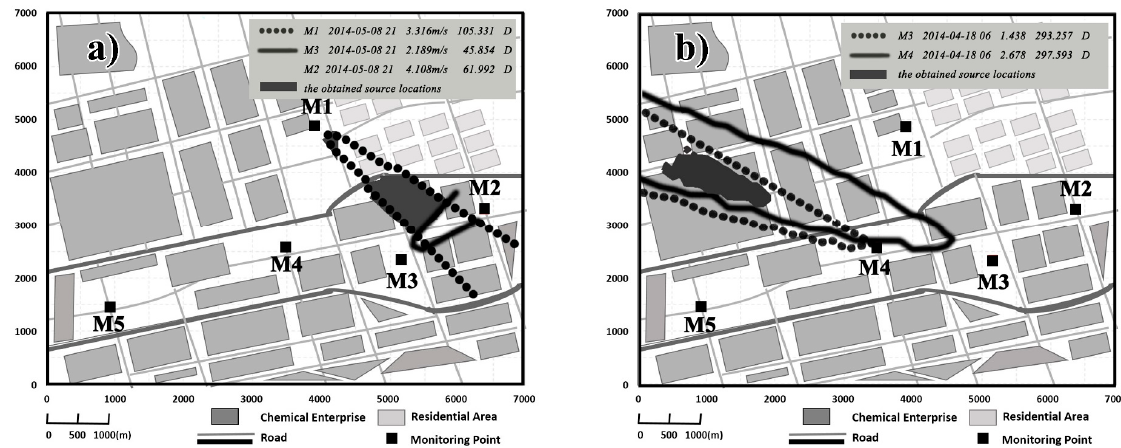
Figure 10. Source area results of the typical scenarios with multiple sites used for source identification: ( a ) the results of the scenario of multiple sites for source identification, but with only one site with the abnormally elevated concentration; ( b ) the results of the scenario of two violation sites’ measurements used for source identification.